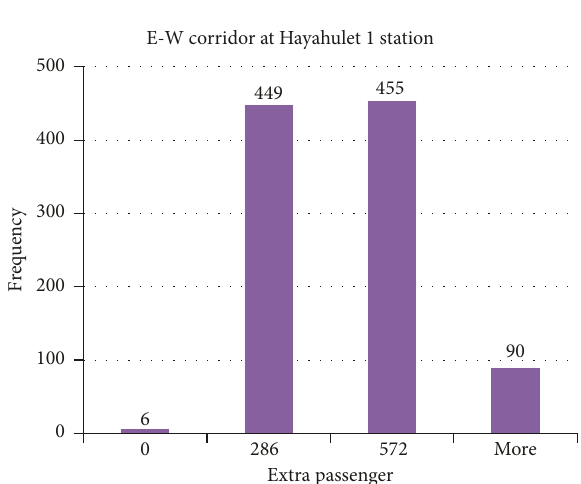
Figure 4: Histogram representation of extra passengers at Haya Hulet 1 station.